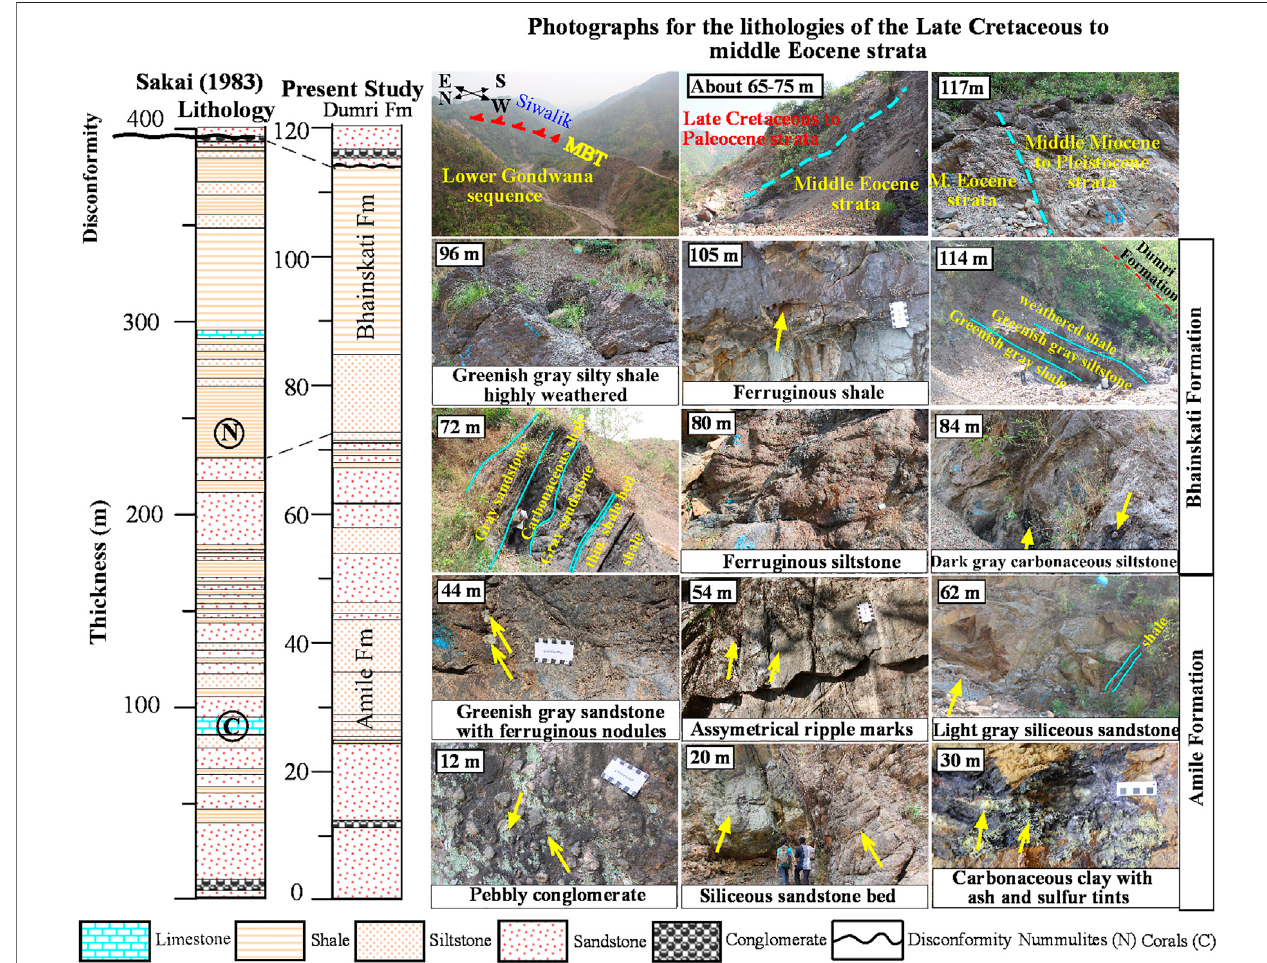
FIGURE 2 | Lithostratigraphic correlation of the Amile (late Cretaceous-Paleocene) and Bhainskati (middle Eocene) formations between the present and previous studies. The fi eld photographs from 12 to 62 m represent Amile Formation and from 72 to 114 m represent Bhainskati Formation. The boundary between late Cretaceous-Paleocene and middle Eocene strata exists nearly at 65 – 75 m. In addition, the boundary between middle Eocene and middle Miocene toPleistocene strata exists nearly at 117 m. These photographs show the distinct lithologies from both formations in the Palpa section.